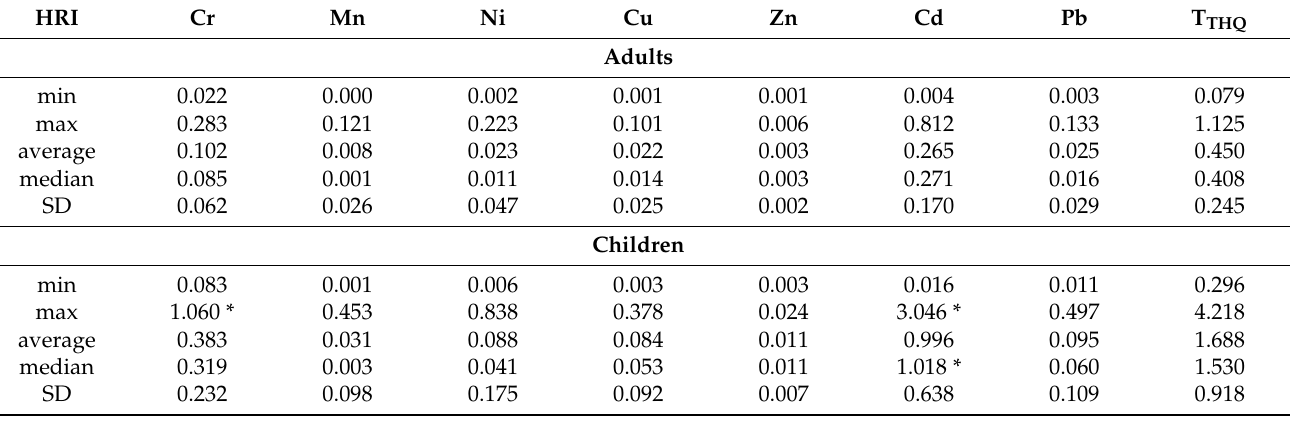
* Indicates the problematic values.